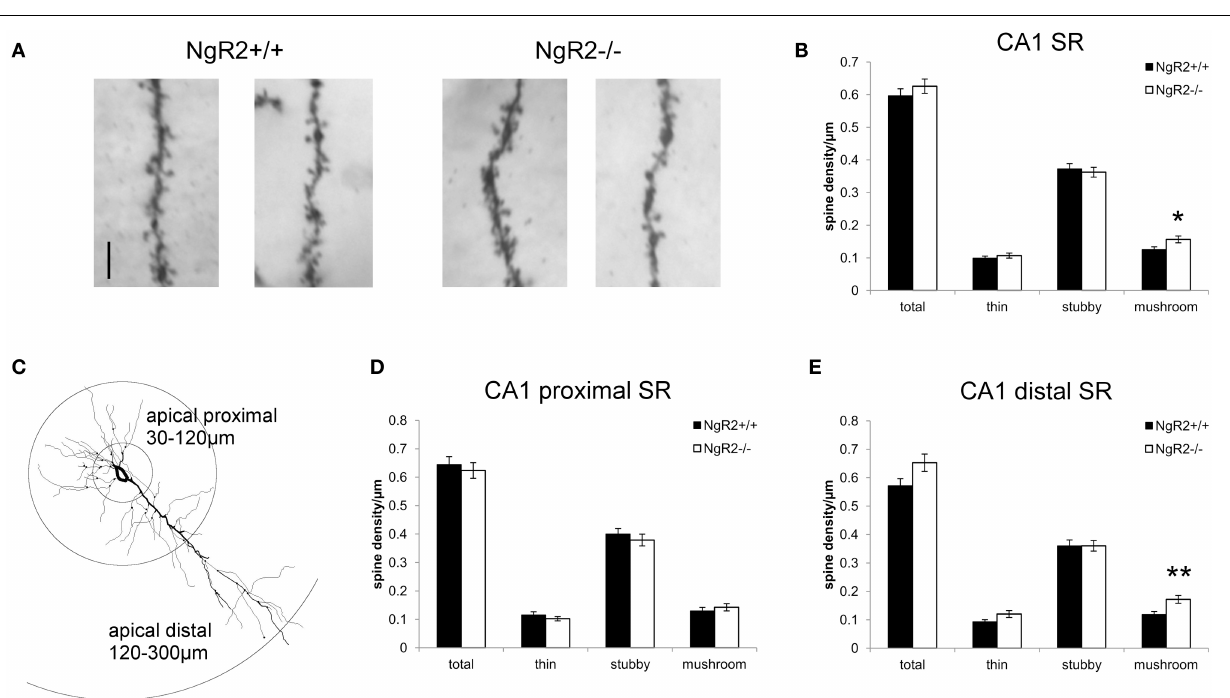
FIGURE 2 | NgR2 − / − mice have an altered distribution of dendritic spine morphologies in CA1 hippocampal neurons. (A) Representative images of dendritic spines of adult NgR2 + / + and NgR2 − / − CA1 apical tertiary dendrites from Golgi-Cox staining. (B) Quantification of spine densities for each morphological criteria in CA1 apical tertiary dendrites revealed a significant increase in mushroom type spines in NgR2 − / − compared to NgR2 + / + . (C) Example of a CA1 pyramidal neuron reconstructed in Neurolucida explorer